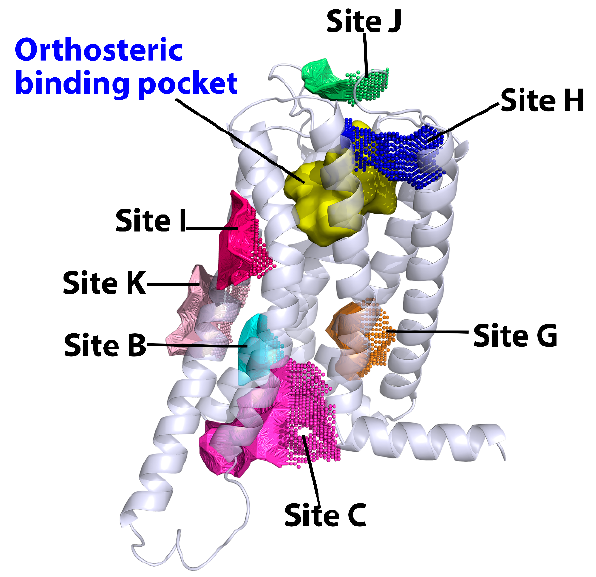
Figure 1. Predicted allosteric binding sites of CB2 by CavityPlus, Protein Allosteric and Regulatory Sites (PARS) and Sybyl-X. The orthosteric binding site was highlighted in yellow surface, while predicted allosteric sites are highlighted in dots.